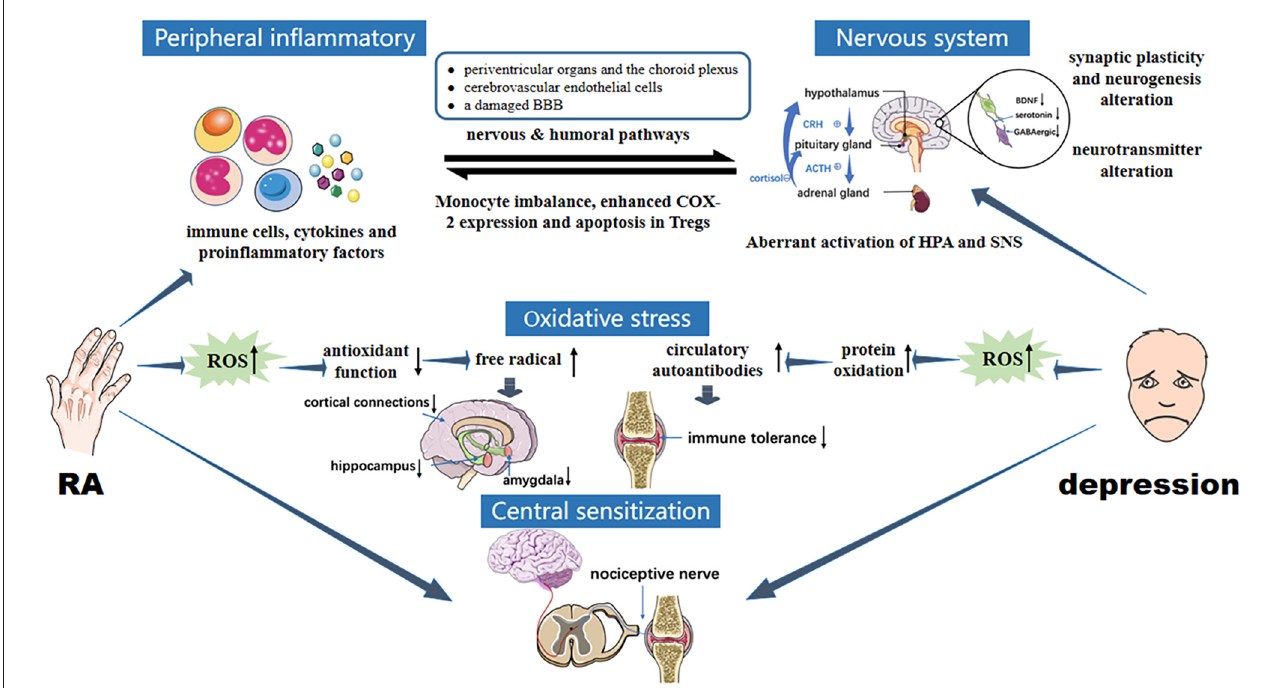
FIGURE2 Pathology of interaction between RA and depression. RA immune tolerance imbalance induces abnormal expression of inflammatory mediators, activated peripheral inflammatory signals enter the brain through humoral and neural pathways. CNS inflammation is induced, as are overactivation of HPA, changes in brain structure and function, upregulation of glutamate levels, reduced GABA expression and brain-derived neurotrophic factors, enhanced oxidative stress, and increased ROS levels, leading to depression. In the two-way feedback between RA and depression, the transduction of immune and inflammatory signals in and out of cells mainly involves JAK/STAT and MAPK signaling cascades. In addition, central sensitization enhances pain perception and aggravates depression under the stimulus of chronic inflammation in RA. Oversensitivity caused by depression in turn exacerbates pain, creating a vicious circle between RA and